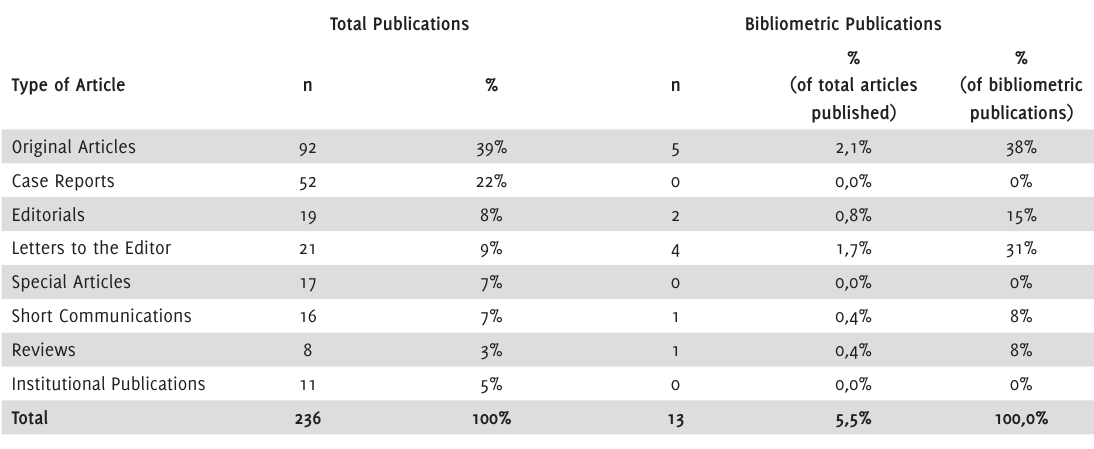
Table 1. Description of Published Articles by Article Type and Bibliometric Methodology in a Latin-American Medical Students' Journal between 2001 and 2011.